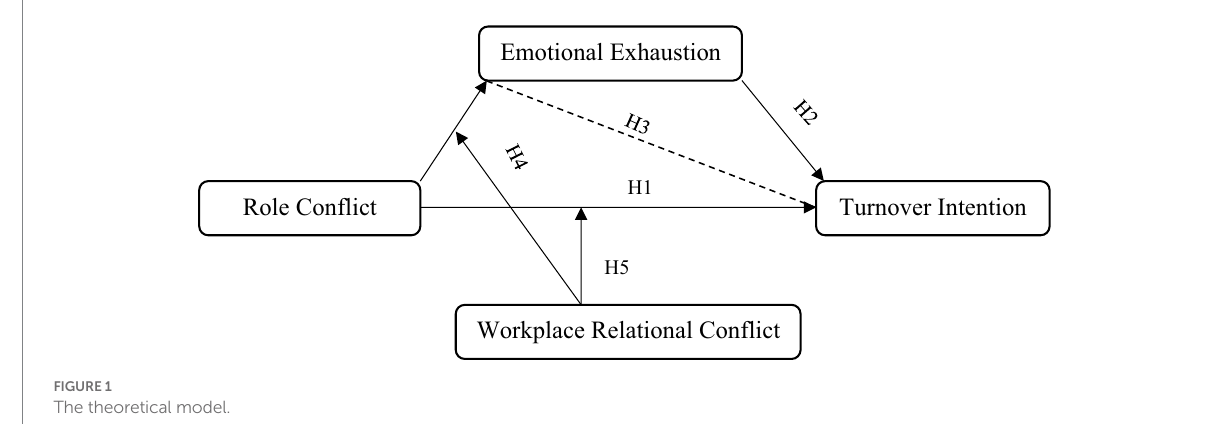
FIGURE 1 The theoretical model.